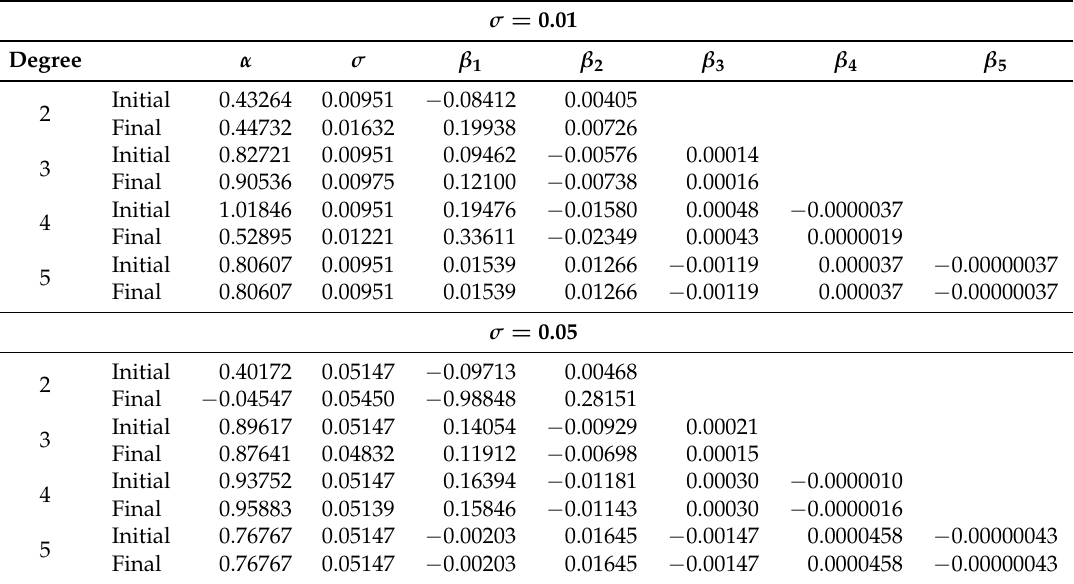
Table 1. Example 1. Estimates of the parameters of the models for each value of p . σ = 0.01